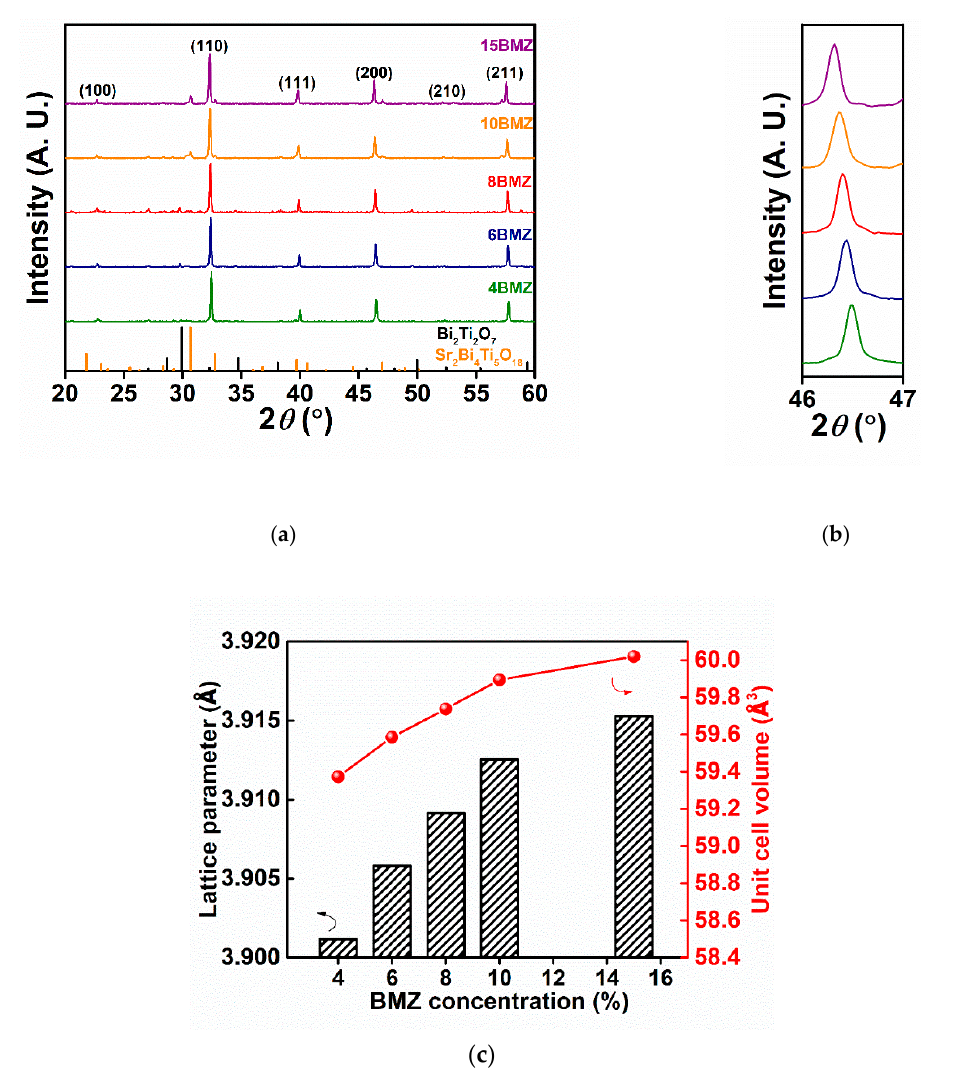
Figure 1. ( a ) XRD patterns of (1 − x )(Sr 0.7 Bi 0.2 )TiO 3 - x Bi(Mg 0.5 Zr 0.5 )O 3 ceramics; ( b ) enlarged diffraction peaks from 46° to 47° of (1 − x )(Sr 0.7 Bi 0.2 )TiO 3 - x Bi(Mg 0.5 Zr 0.5 )O 3 ceramics; ( c ) the lattice parameters as a function of BMZ concentration.